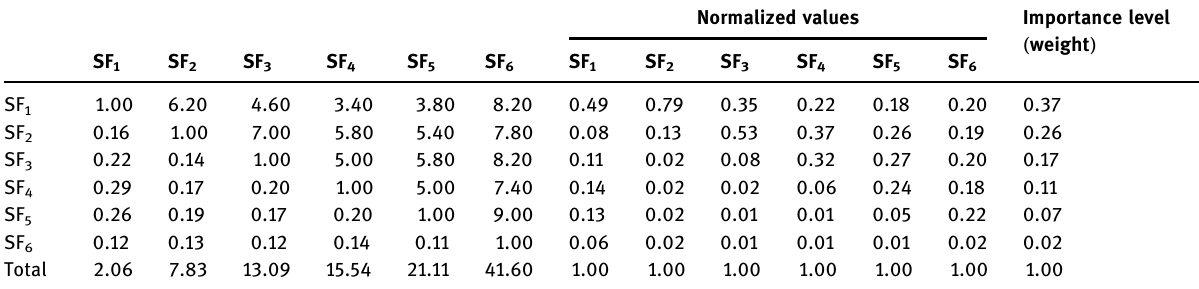
Table 8: Calculating the importance levels of success factors